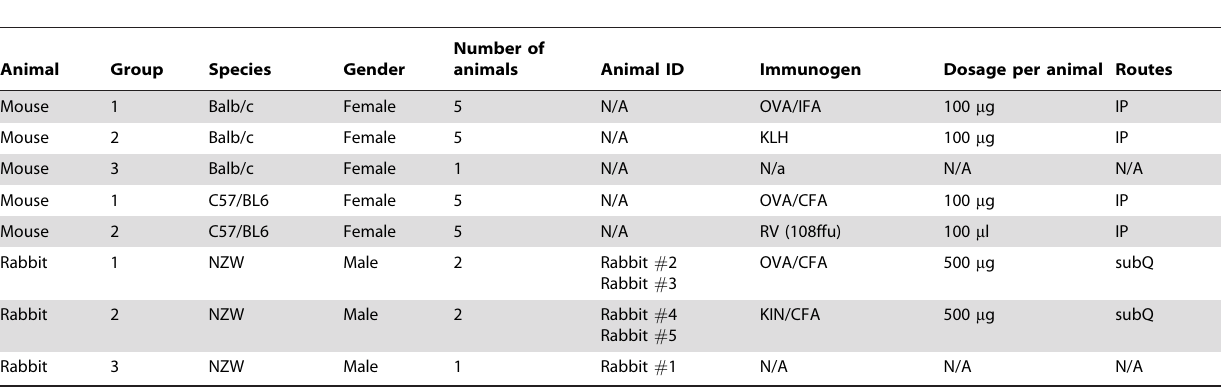
Table 1. Animals, immunogens and routes of immunogen administration that were used in the mice and rabbit immunization studies.